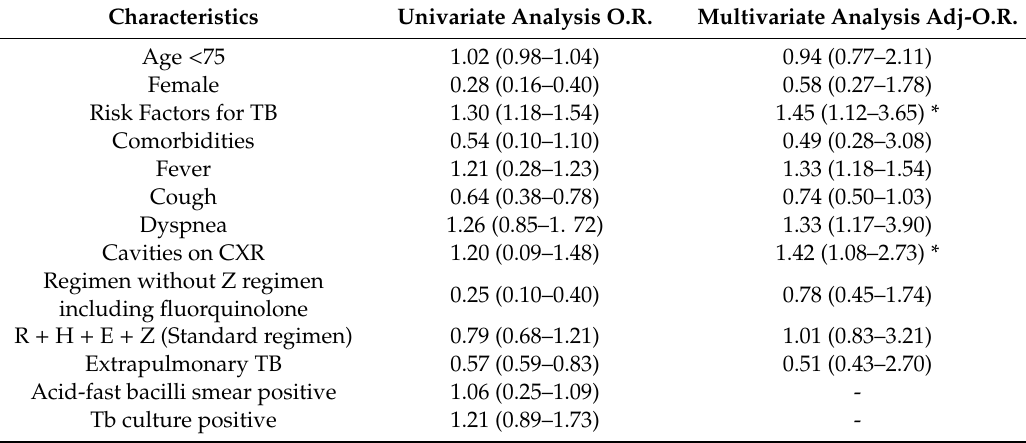
Table 3. Predictors of adverse events for active pulmonary tuberculosis in elderly patients.